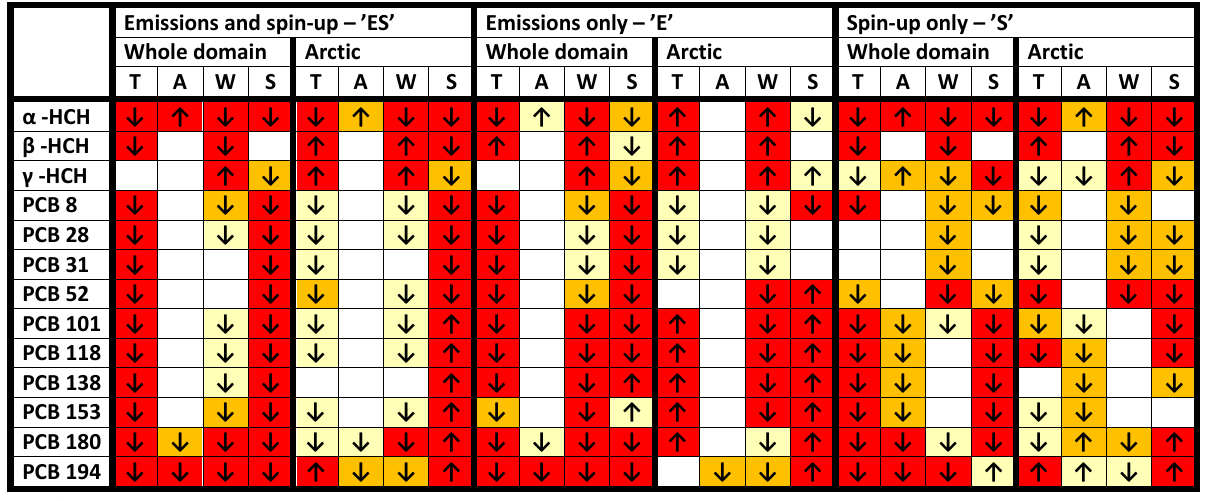
Table 1. Differences in mass between the two time slices for the three simulations within the whole domain and within the Arctic in total ( T ), in air ( A ), in water ( W ), and in soil ( S ). ↓ displays lower mass in the 2090s than in the 1990s and ↑ displays higher mass in the 2090s than in the 1990s. Only differences with significance levels lower than 0.1 are shown. The background colours display the statistical significance, red displays significance levels lower than 0.001, orange displays significance levels lower than 0.01, and yellow displays significance levels lower than 0.1.